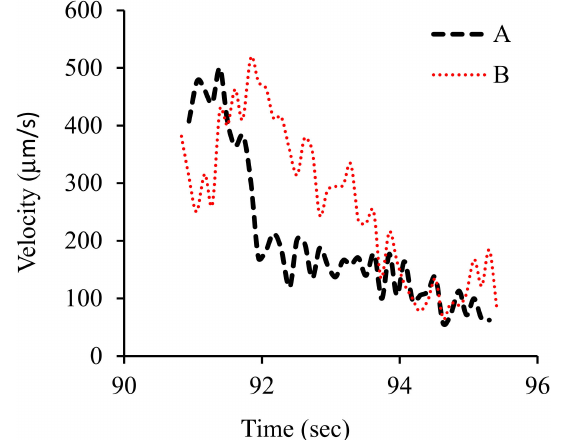
Figure 6. Variation in velocity of nanoparticles as a function of time. Nanoparticles were circling ( A ) and moving outward ( B